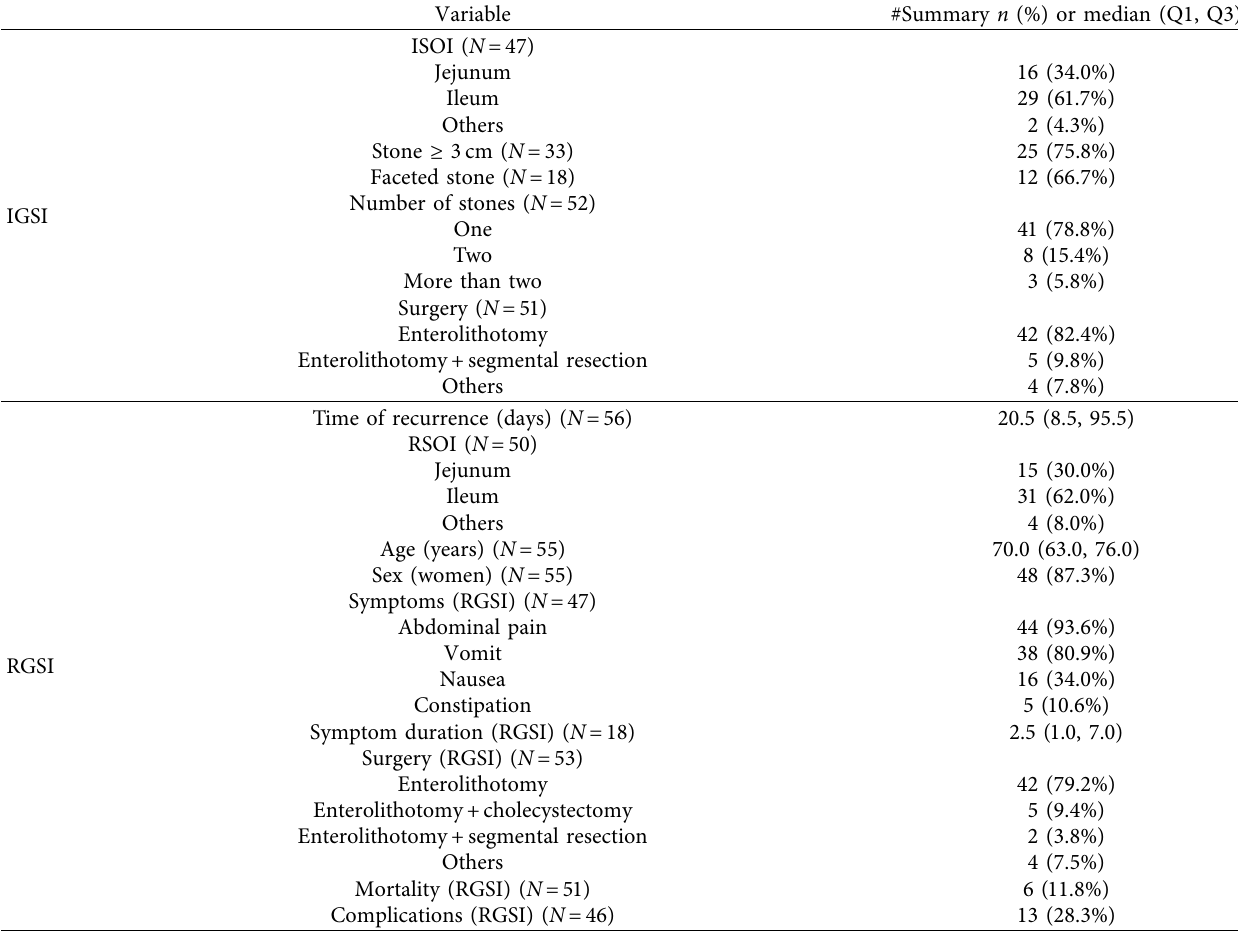
Table 1: Demographic and clinical characteristics of